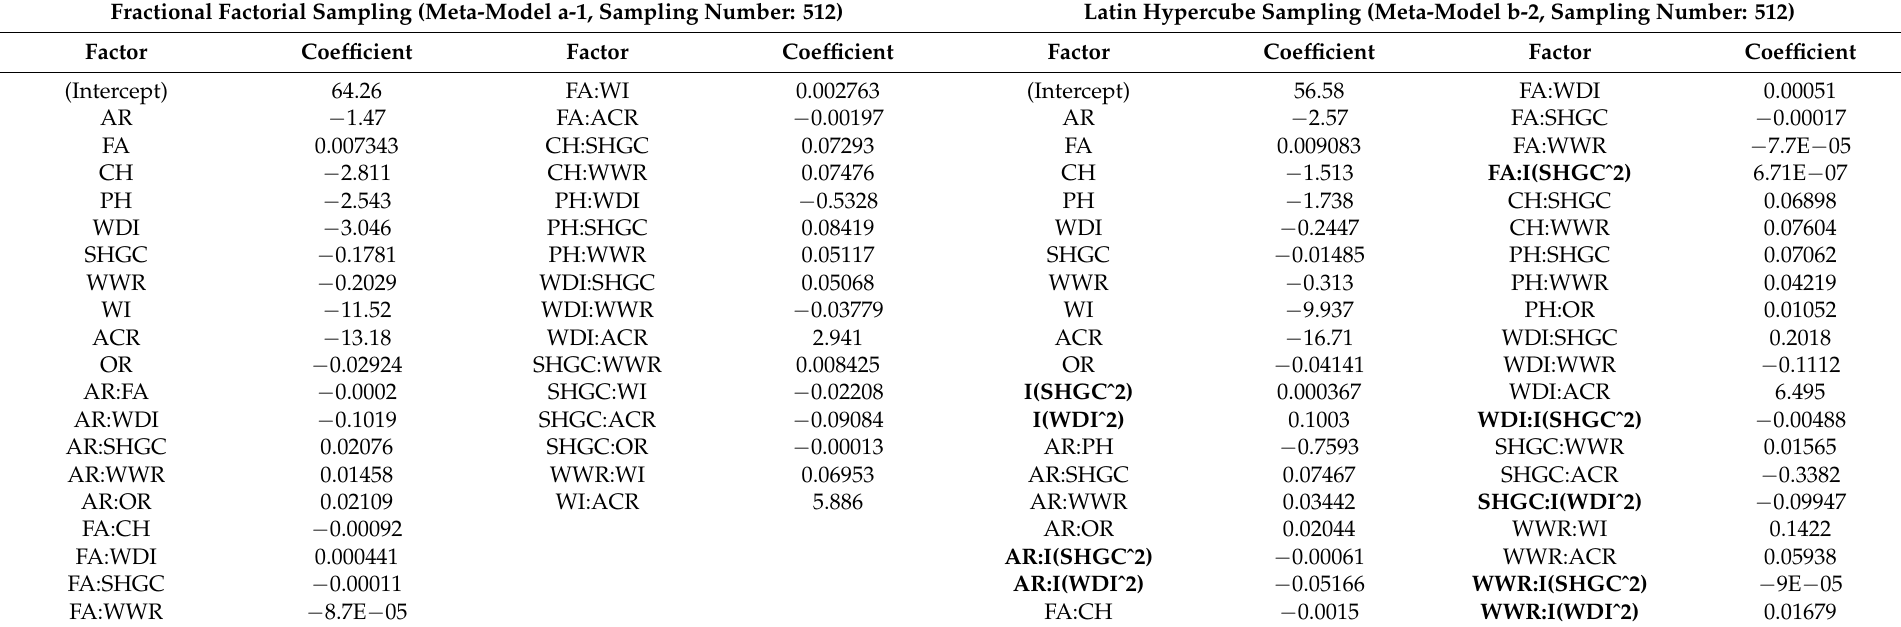
Table A2. List of the main effect and interaction terms and coefficients of Equation (1) for the cooling load of the building. Fractional Factorial Sampling (Meta-Model a-1, Sampling Number: